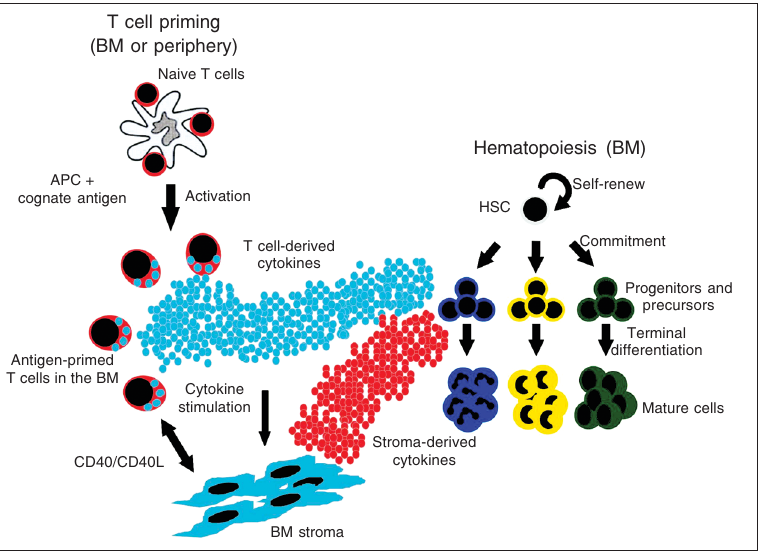
Figure 1. Model of “adaptive” T cell-instructed hematopoiesis. T cells are primed by the cognate antigen and reach the bone marrow, where they can help hematopoiesis by i) direct cytokine production; ii) inducing cytokine production by the bone marrow stromal cells (through cytokines or cellular interaction). These cytokines act by promoting terminal differentiation of myeloid progenitors. BM = bone marrow; APC = antigen-presenting cell; HSC = hematopoietic stem